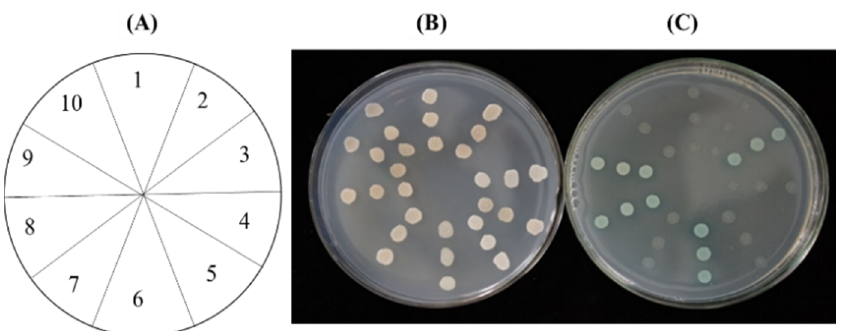
Figure 5. Interaction of Cp GPPS.SSUs with Cp GGPPSs and At GGPPS11. ( A ) Key: 1, BD- Cp SSU1 + AD-empty; 2, BD- Cp SSU1 + AD- Cp GGPPS1; 3, BD- Cp SSU1 + AD- Cp GGPPS2; 4, BD- Cp SSU1